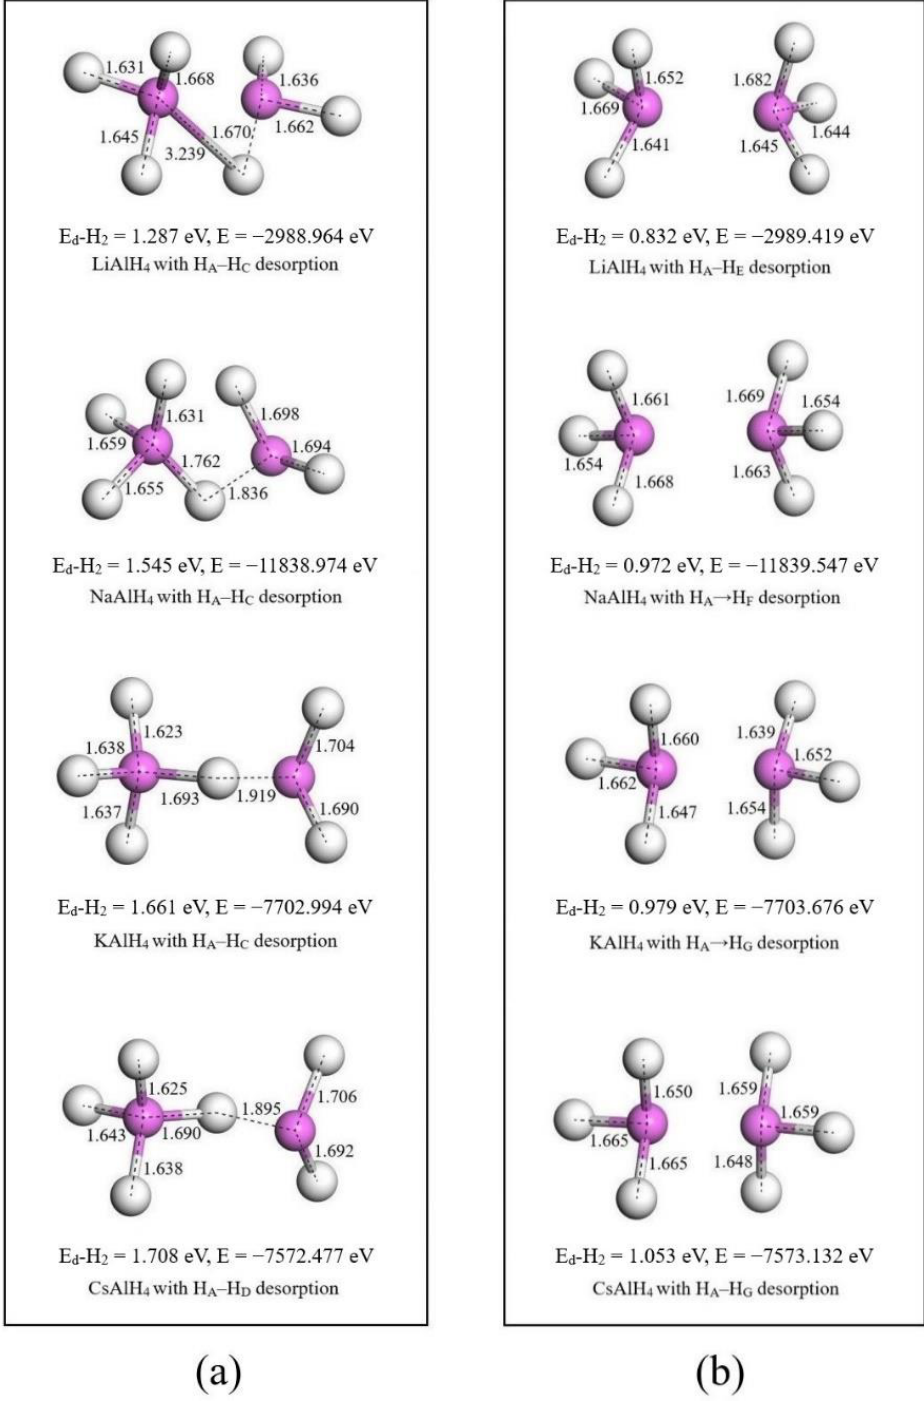
Figure 3. The formed AlH 3 group, hydrogen dissociation energy (E d -H 2 ), and total energy (E) for MAlH 4 (M = Li, Na, K, and Cs) with H A and H X desorption: ( a ) H A and H X from one [AlH 4 ] unit; ( b ) H A and H X from two [AlH 4 ] units. The bond lengths between Al and H atoms in AlH 3 group are described (in Ǻ).